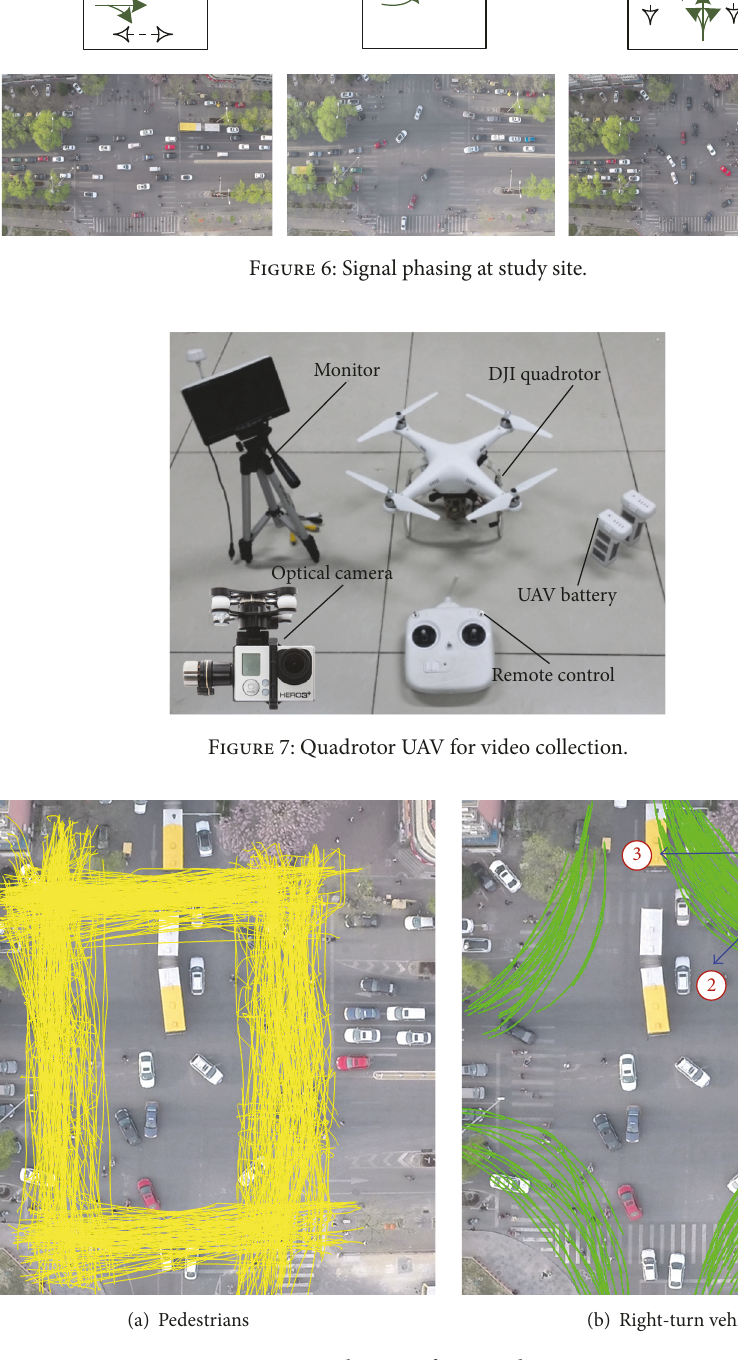
Figure 8: Visualization of extracted